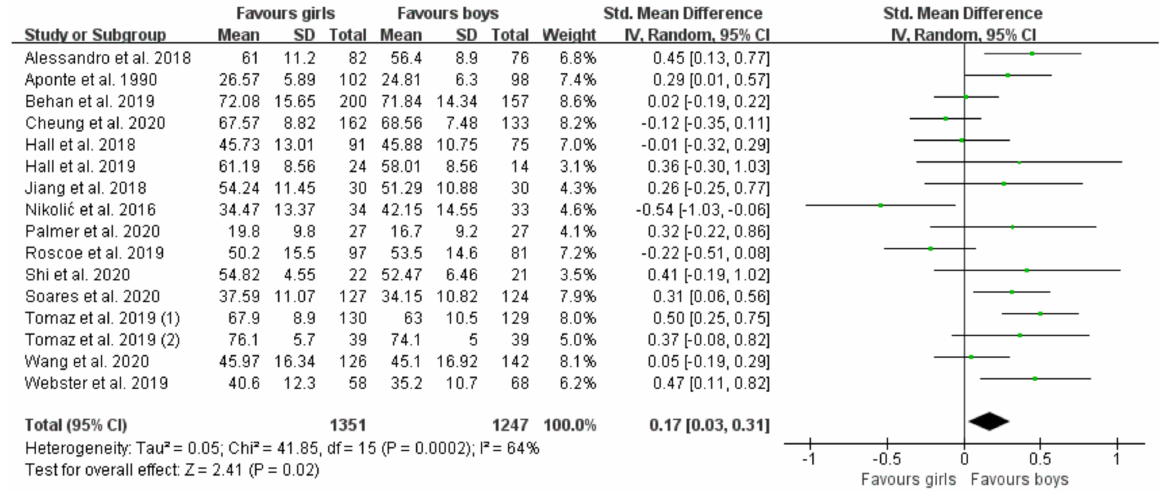
Figure 2. Forest plot of total FMS scores